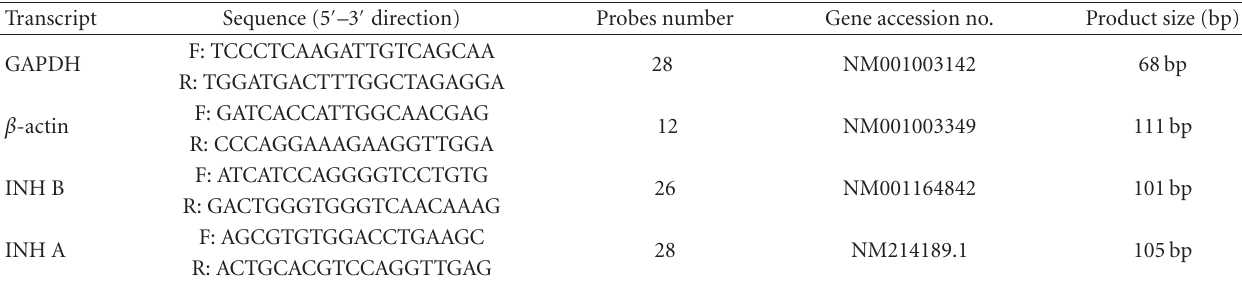
Table 1: Oligonucleotide sequences and primer probes used for RQ-PCR